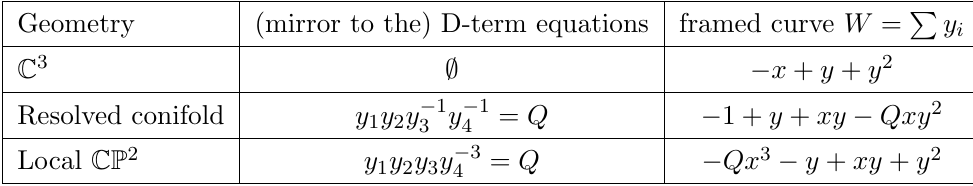
Table 2. Framed mirror